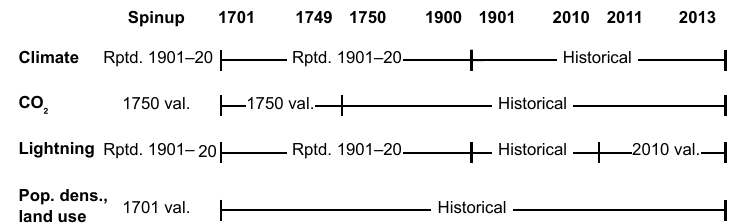
Figure 2. Timelines describing how the different input datasets were used in the spinup and historical model runs. The x axis is not to scale. “Historical”: Time series of observation-based data. “Rptd. 1901–20”: Repeated time series of values from 1901 to 1920. “YEAR val.”: Variable held constant at value for year